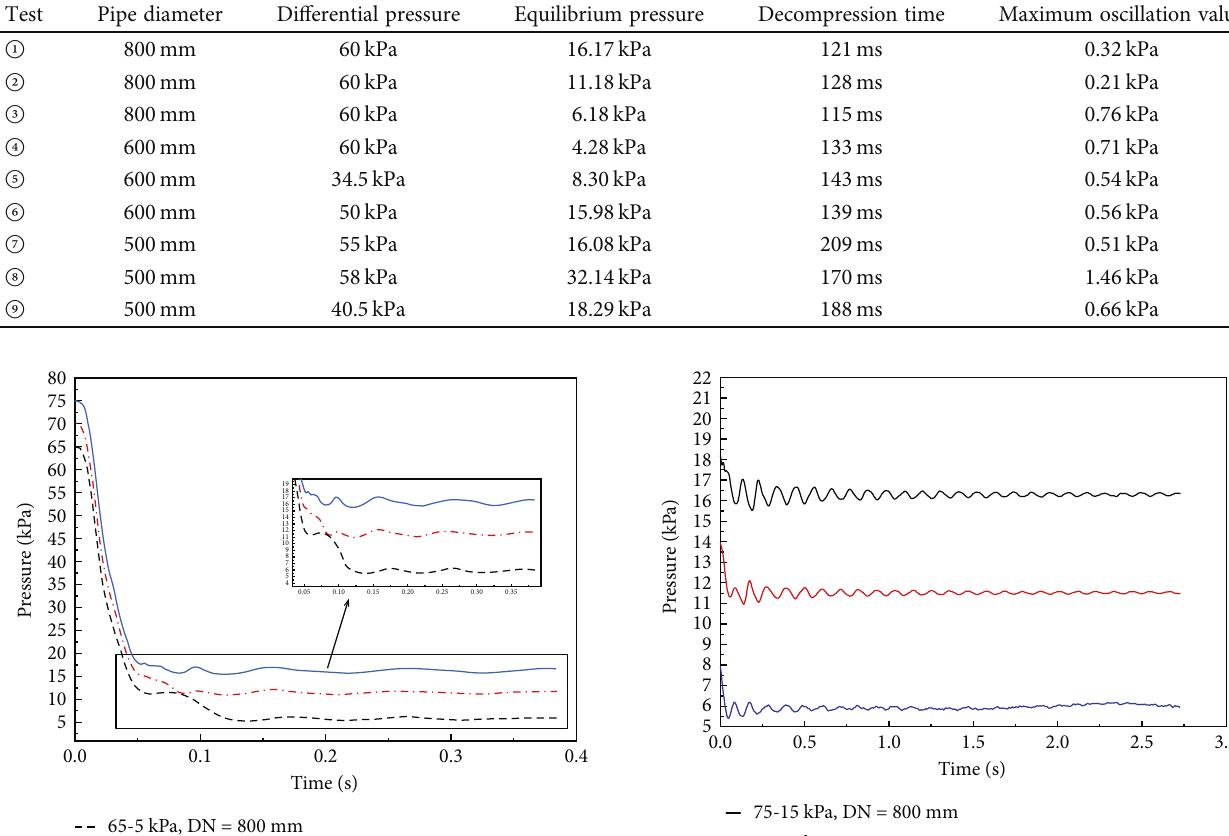
Table 2: Orthogonal experimental design.